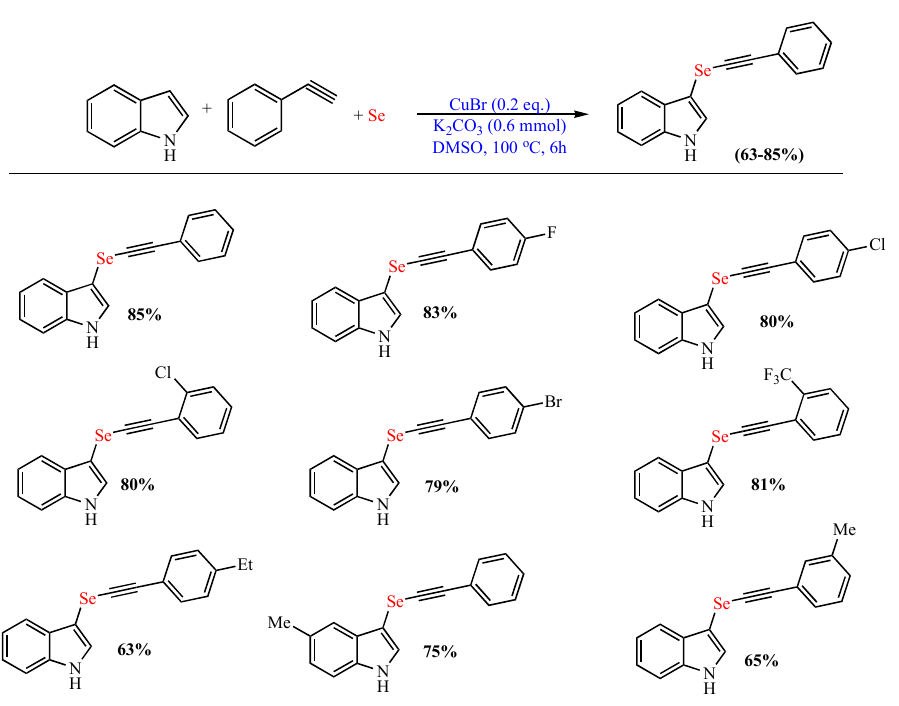
Scheme 7. Synthesis of 3-((arylethynyl)selanyl)-1 H -indoles.